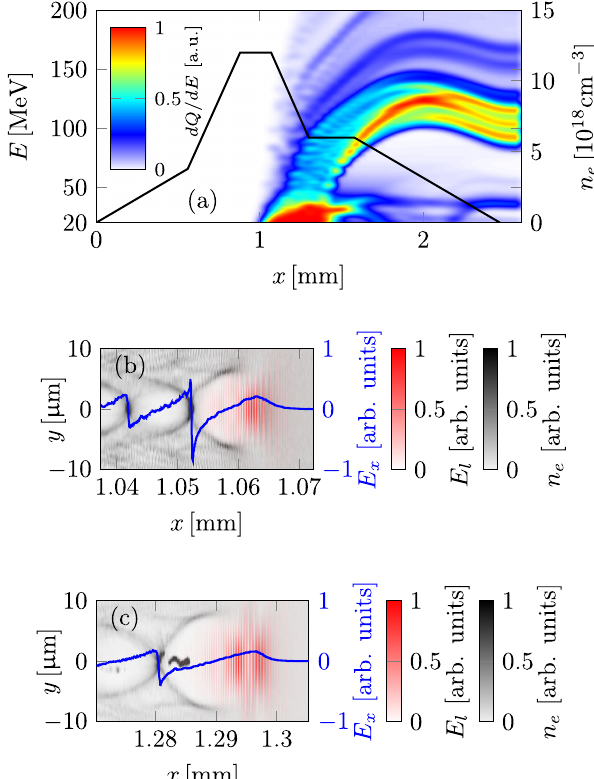
FIG. 6. Simulated evolution of the electron spectrum as the laser pulse propagates through the plasma (a) and local electron number density distribution before (b) and after (c) the density down-ramp along with the laser field (red) and accelerating electric field (blue). Injection of electrons into the wakefield structure occurs in the density down-ramp, located between ≈ 1 . 1 mm and ≈ 1 . 35 mm. The injected electrons are accelerated in the density plateau and the final electron energy spectrum contains a peak centered around 105 MeV and a FWHM of 20 MeV. In (c) electrons have been trapped after being injected as the plasma wavelength gradually increased in the density down- ramp. Thus, the electrons are distributed longitudinally over a distance approximately equal to Δ λ p ≈ 5 μ